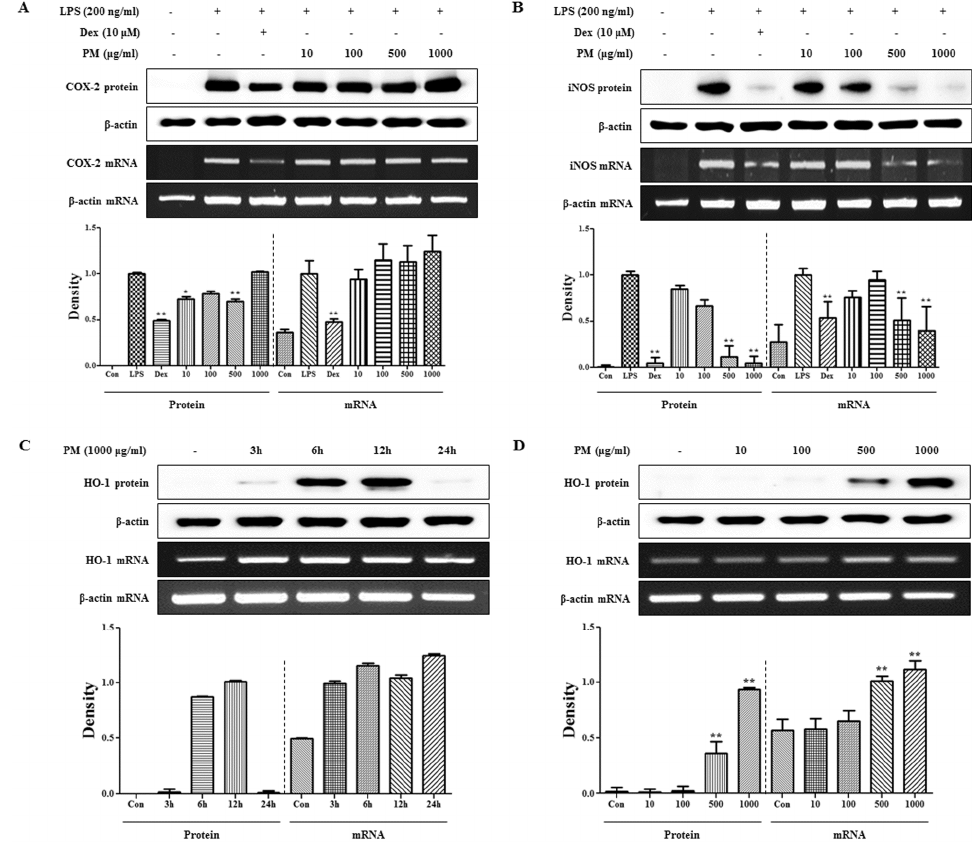
Figure 2. Inhibitory effect of PM on expression of ( A ) COX-2 and ( B ) iNOS . And the inductive effect of PM on ( C , D ) HO-1 in macrophages. Cells were treated with ( A , B ) LPS alone or LPS plus PM for 24 h and ( C , D ) with PM alone for the indicated time periods. Protein levels were determined by Western blot analysis, as described in the Materials and Methods, and quantitated using the Davinch-chemi™ CAS-400SM Chemiluminescence Imaging System (Core Bio, Seoul, Korea). Expression of mRNA was analyzed by RT-PCR. * p < 0.01 and ** p < 0.001 were calculated via comparisons with the ( A , B ) LPS-stimulation value or ( D ) vehicle